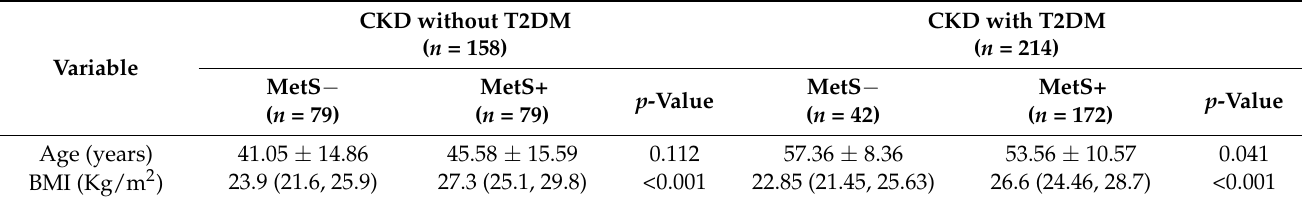
Table 1. Comparison of clinical characteristics of male patients according to the Chinese Guidelines for the Prevention and Treatment of Type 2 Diabetes (2020